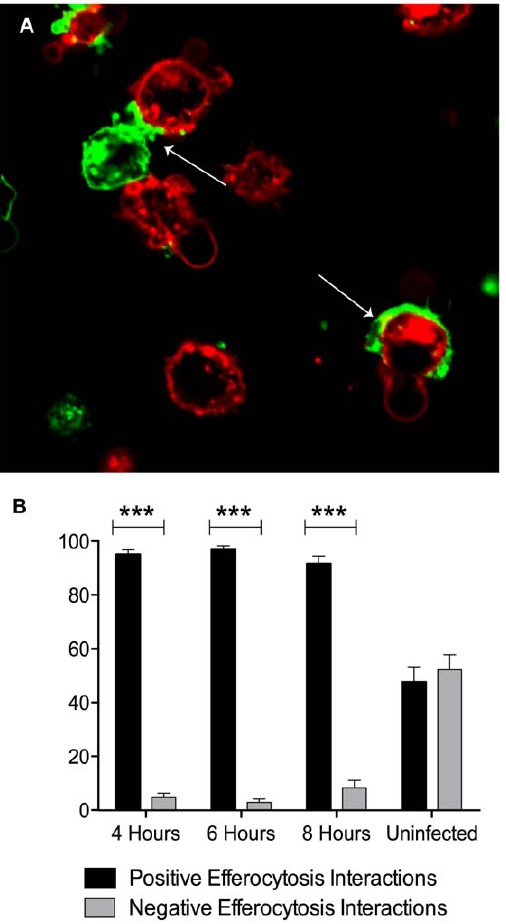
Figure 1. Attempted engulfment of M.tb -infected macrophages by naı¨ve macrophages is incomplete and unidirectional. ( A ) Infected macrophages ( red ) were co-cultured with uninfected macro- phages ( green ) for 3 h. Samples were fixed and observed by laser- scanning confocal microscopy. White arrow identifies early contact points where naı¨ve macrophages form pedestals or partially engulf infected macrophages. ( B ) Directionality of frustrated efferocytosis was quantified by counting the number of ‘‘positive’’ interactions, ones in which naı¨ve macrophages form pedestals or partially engulf infected macrophages, compared to ‘‘negative’’ interactions where cell-cell contact occurred without pedestals or engulfment (all interactions not described as ‘‘positive’’). Results are expressed as the % positive interactions vs. % negative interactions at each time point 6 SD. ***, p , 0.0001 for all time